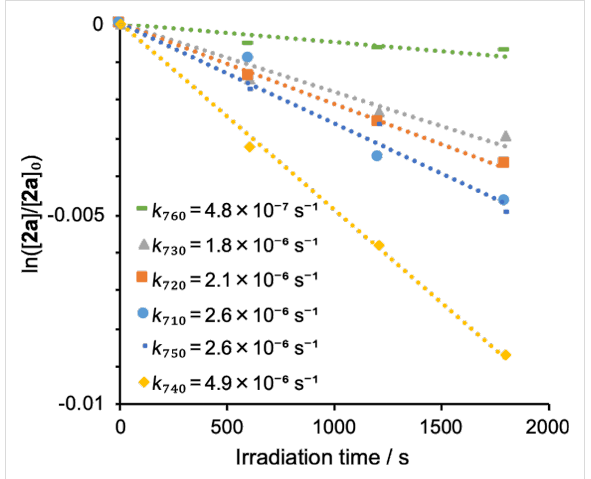
Figure 3: Time profile, ln([ 2a ]/[ 2a ] 0 ) versus irradiation time, of two- photon uncaging reaction of TEMPO in the photolysis of 2a in benzene, at wavelengths of 710–760 nm and power of 700